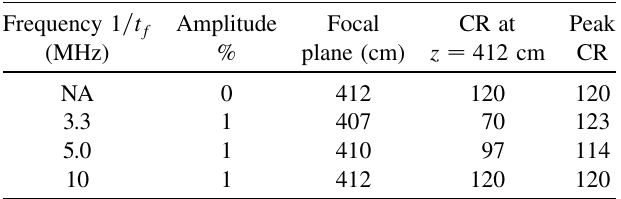
Table II. The beam is injected towards the axis at r (cid:5) 100 cm and diagnosed at r (cid:5) 10 cm .